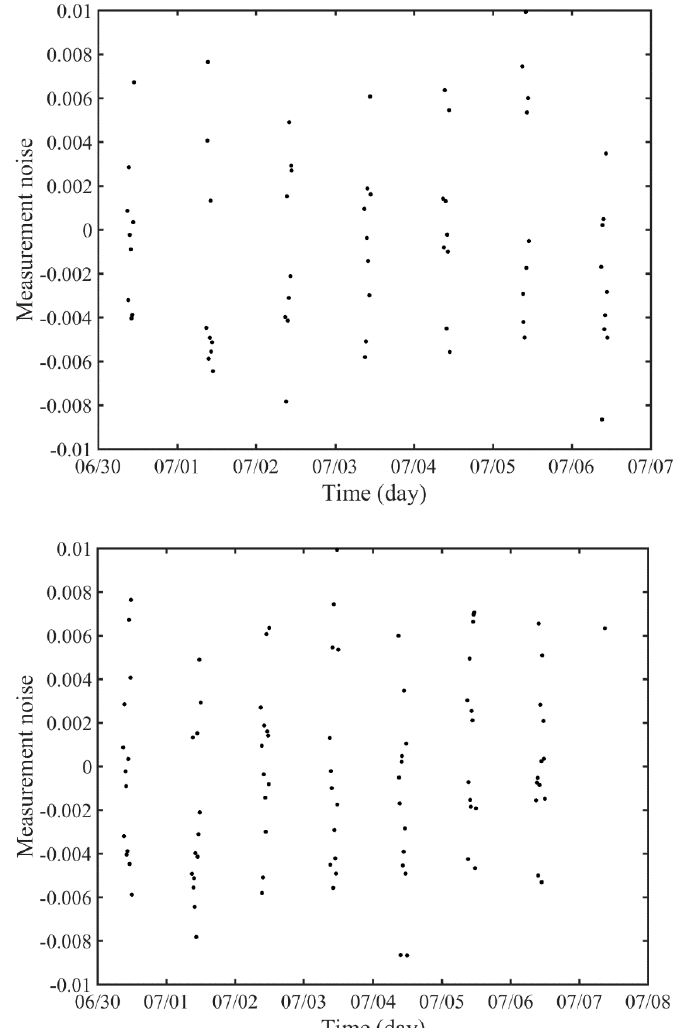
Figure 8. Simulated SLR observations for GK-2B from Geochang ( upper : Scenario 1, lower : Scenario 2).